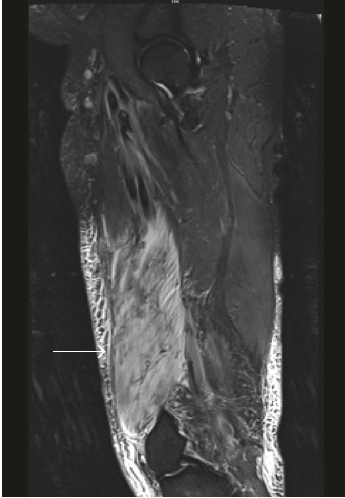
Figure 2: MRI of the left thigh, sagittal section, showing hyperin- tense signals on T2 weighted images (white arrow).